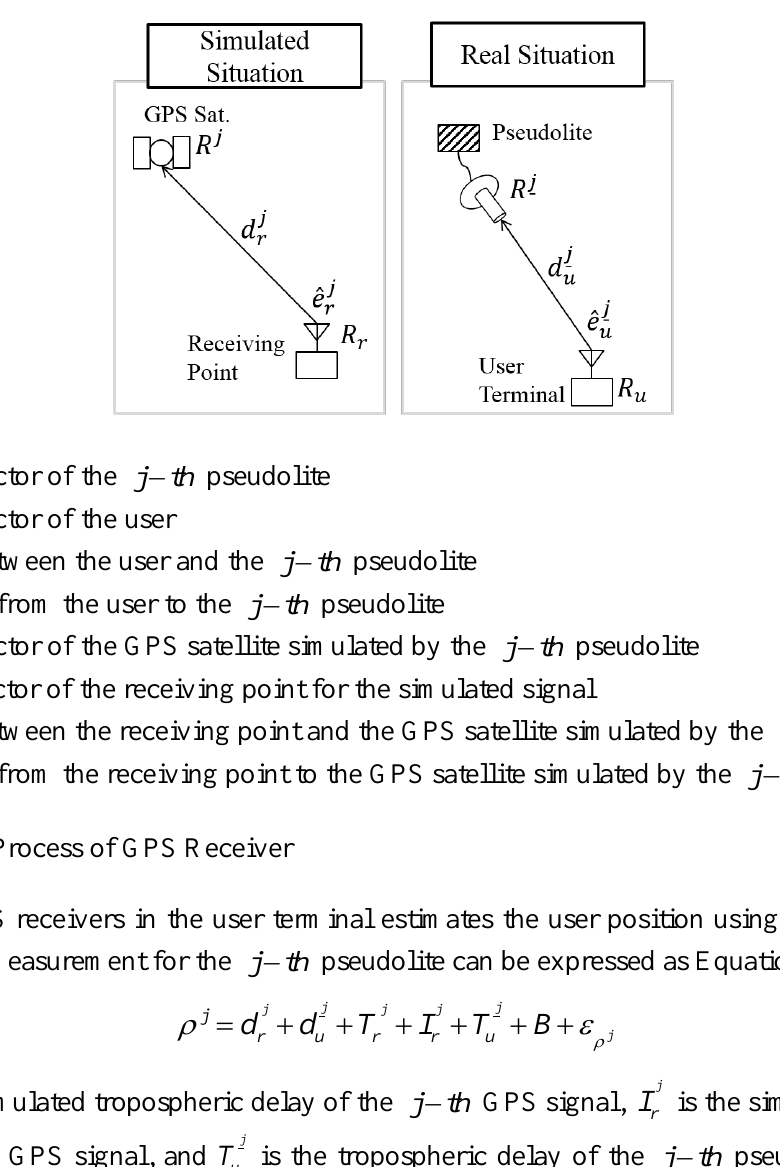
Figure 7. Illustration of j th  pseudolite and user terminal (Simulated and Real